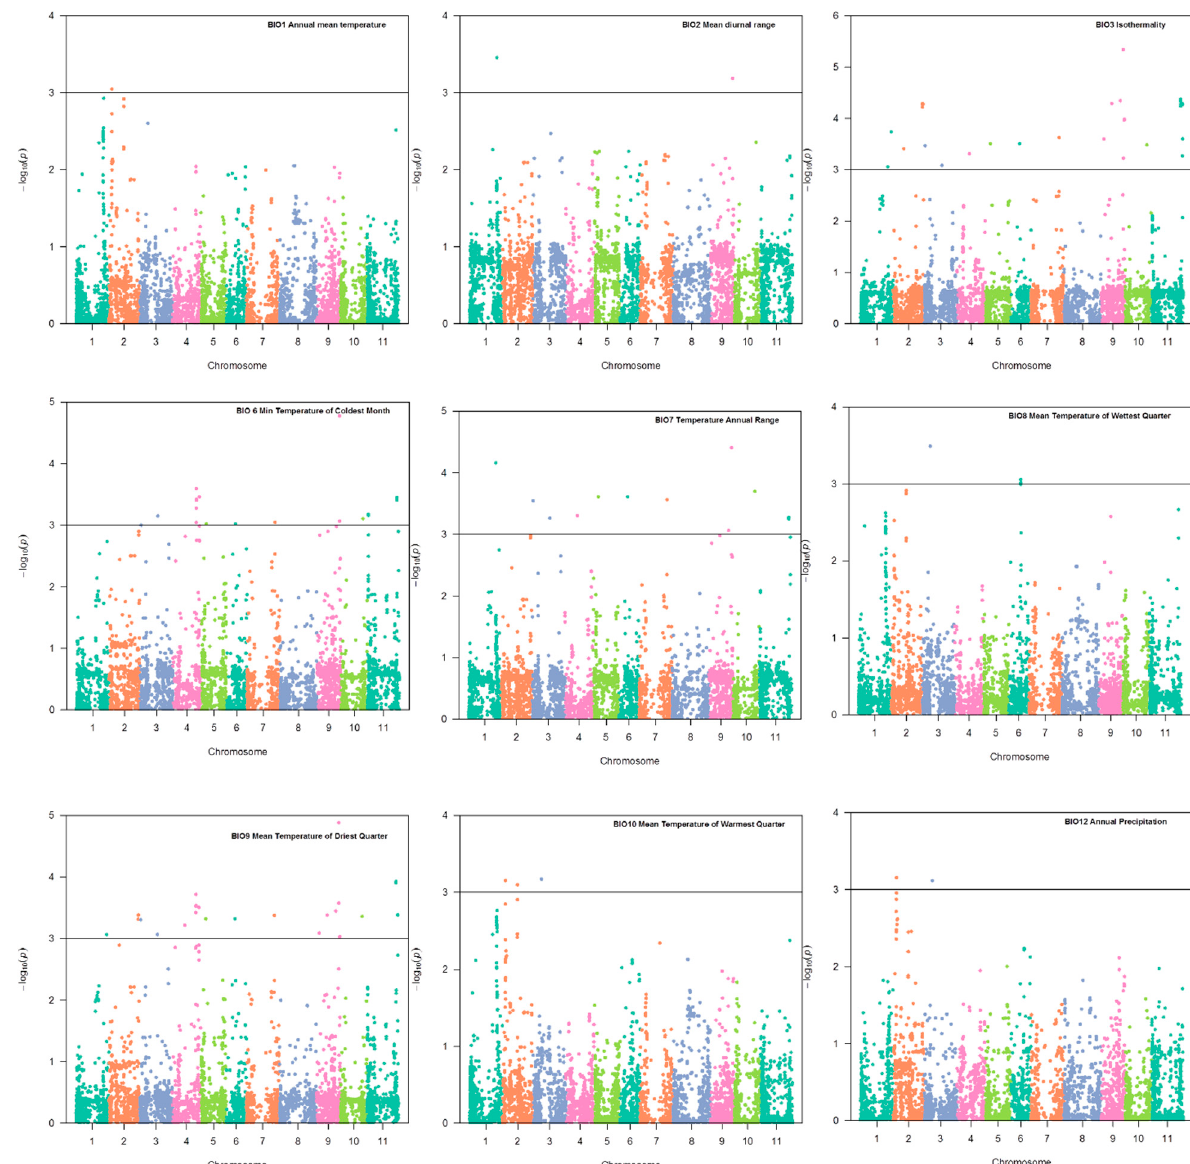
Figure 5. Genome–environment association analysis in common bean accessions. Manhattan plot showing candidate single nucleotide polymorphisms and − log10 ( p -values) for bio-climatic variables BIO1, BIO2, BIO3, BIO6, BIO7, BIO8, BIO9, BIO10, and BIO12. The horizontal black line corresponds to the significance threshold with p -value equal to or smaller than 0.001%.